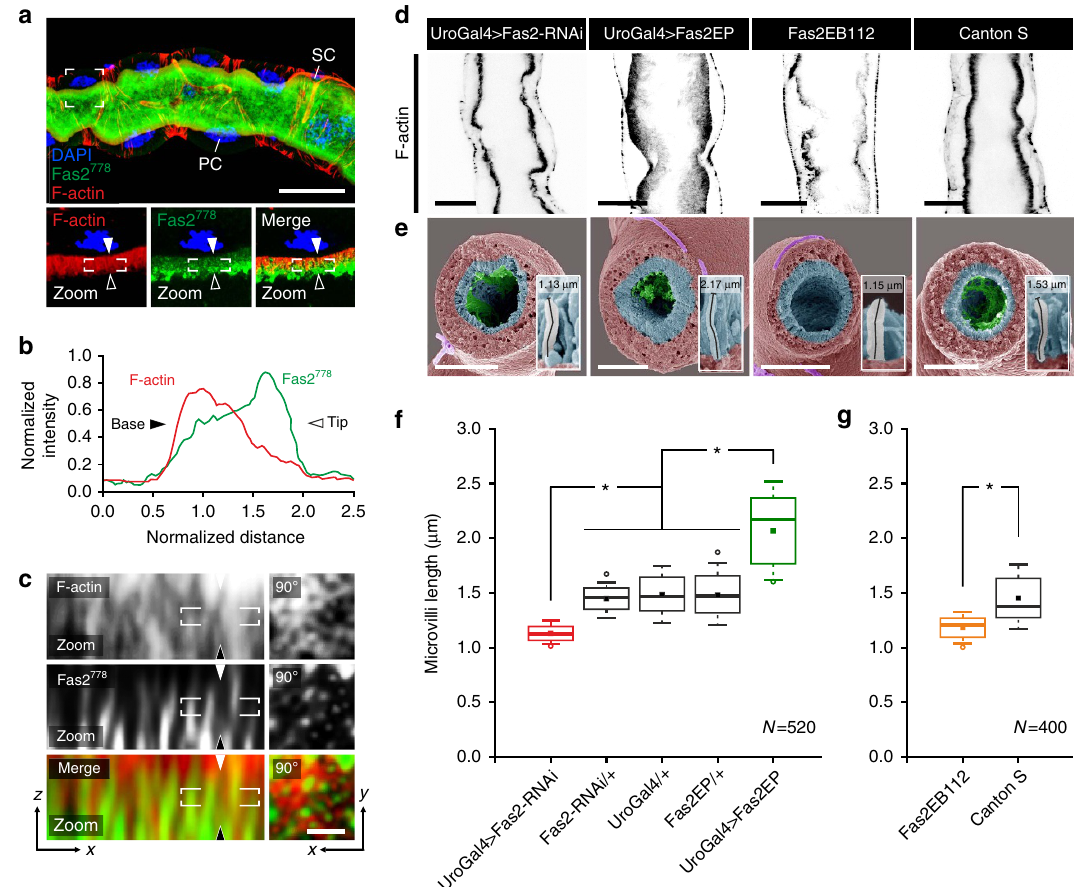
Figure 3 | Genetic manipulation of Fas2 impacts microvilli length. ( a ) Super-resolution confocal microscopy (Airyscan) on MT from Fas2–GFP 778 stained with anti-GFP, suggests that Fas2 localizes to the brush border, where it appears concentrated distally. Zoom: single optical section of the indicated region shown as separate and merged signals. Arrows indicate base (solid) and tip (line) orientations of the brush border. PC, principal cell; SC, stellate cell. Scale bar, 25 m m. ( b ) Mean normalized fluorescent intensity profiles for F-actin and Fas2 signals from N ¼ 12 brush border regions confirm that Fas2 is concentrated at the distal tip of the F-actin-based protrusions. ( c ) Magnification of the white square in ‘ a zoom’, and a perpendicular view (‘90 (cid:2) ’) on the brush border, suggests that Fas2 does not strictly colocalize with intracellular F-actin (phalloidin), but is positioned extracellularly between individual microvilli. Scale bar, 0.5 m m. ( d ) Inverse coloured optical sections of Alexa-488-phalloidin (black) stained MTs from Fas2 knockdown flies (Fas2-RNAi and Fas2EB112) showed a marked decrease in length and density of the microvillar brush border compared with WT (Canton S) tubules. Conversely, overexpression of Fas2 (Fas2-EP) produced notably longer and denser microvilli. Scale bars, 15 m m. ( e ) Scanning electron microscopy (SEM) analysis of MT